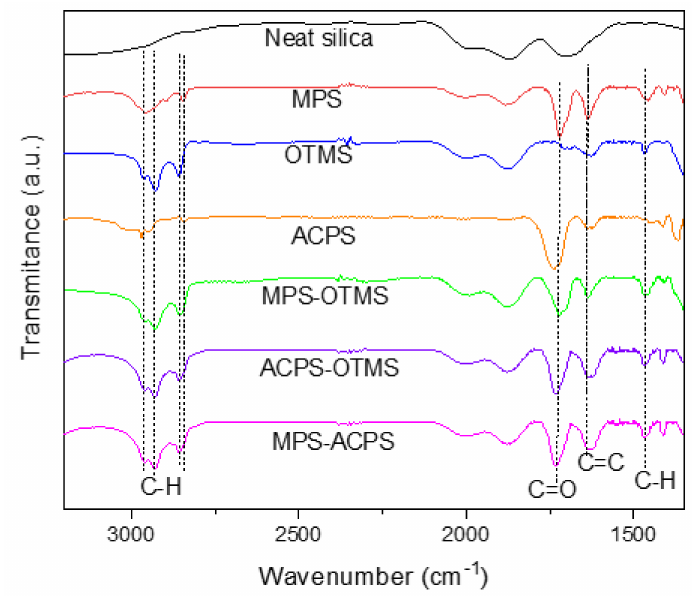
Figure 1. Comparative FTIR spectra between untreated and diverse organomodified silica